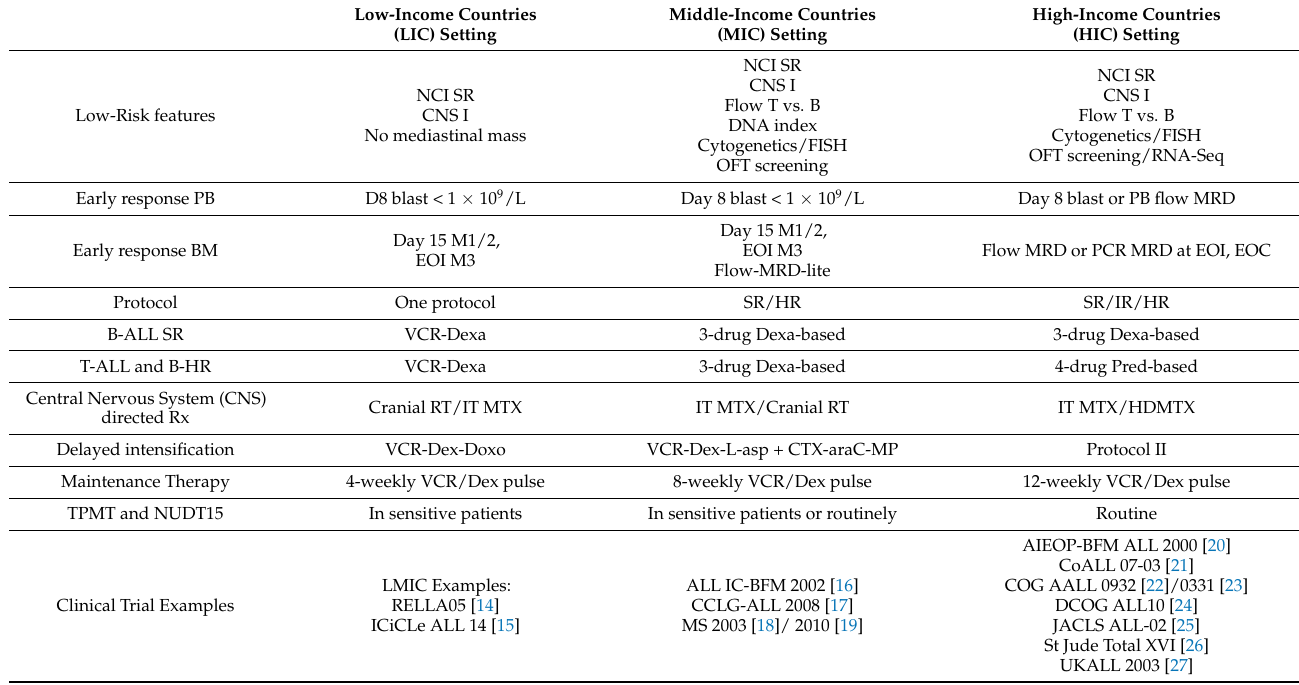
Table 1. Key stratified strategies discussed in this review on management of low-risk childhood ALL. Low-Income Countries (LIC) Setting